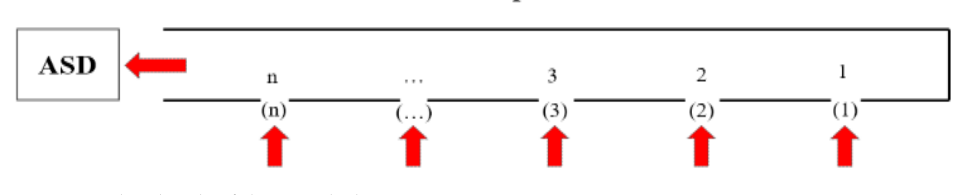
Figure 1. The sketch of the pipe hole.